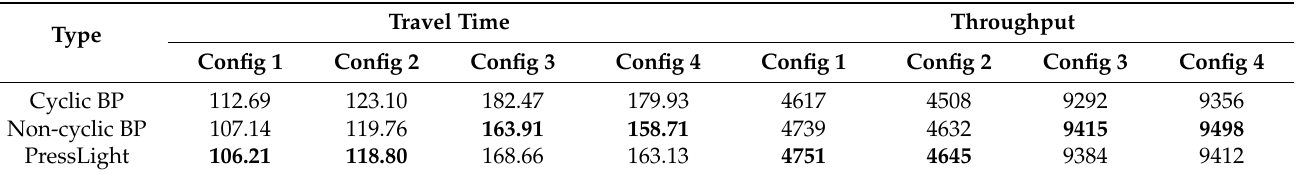
Table 3. Performance comparison of cyclic and non-cyclic phase control on the RN 3 × 3 network within one hour of simulation. Best results are shown in